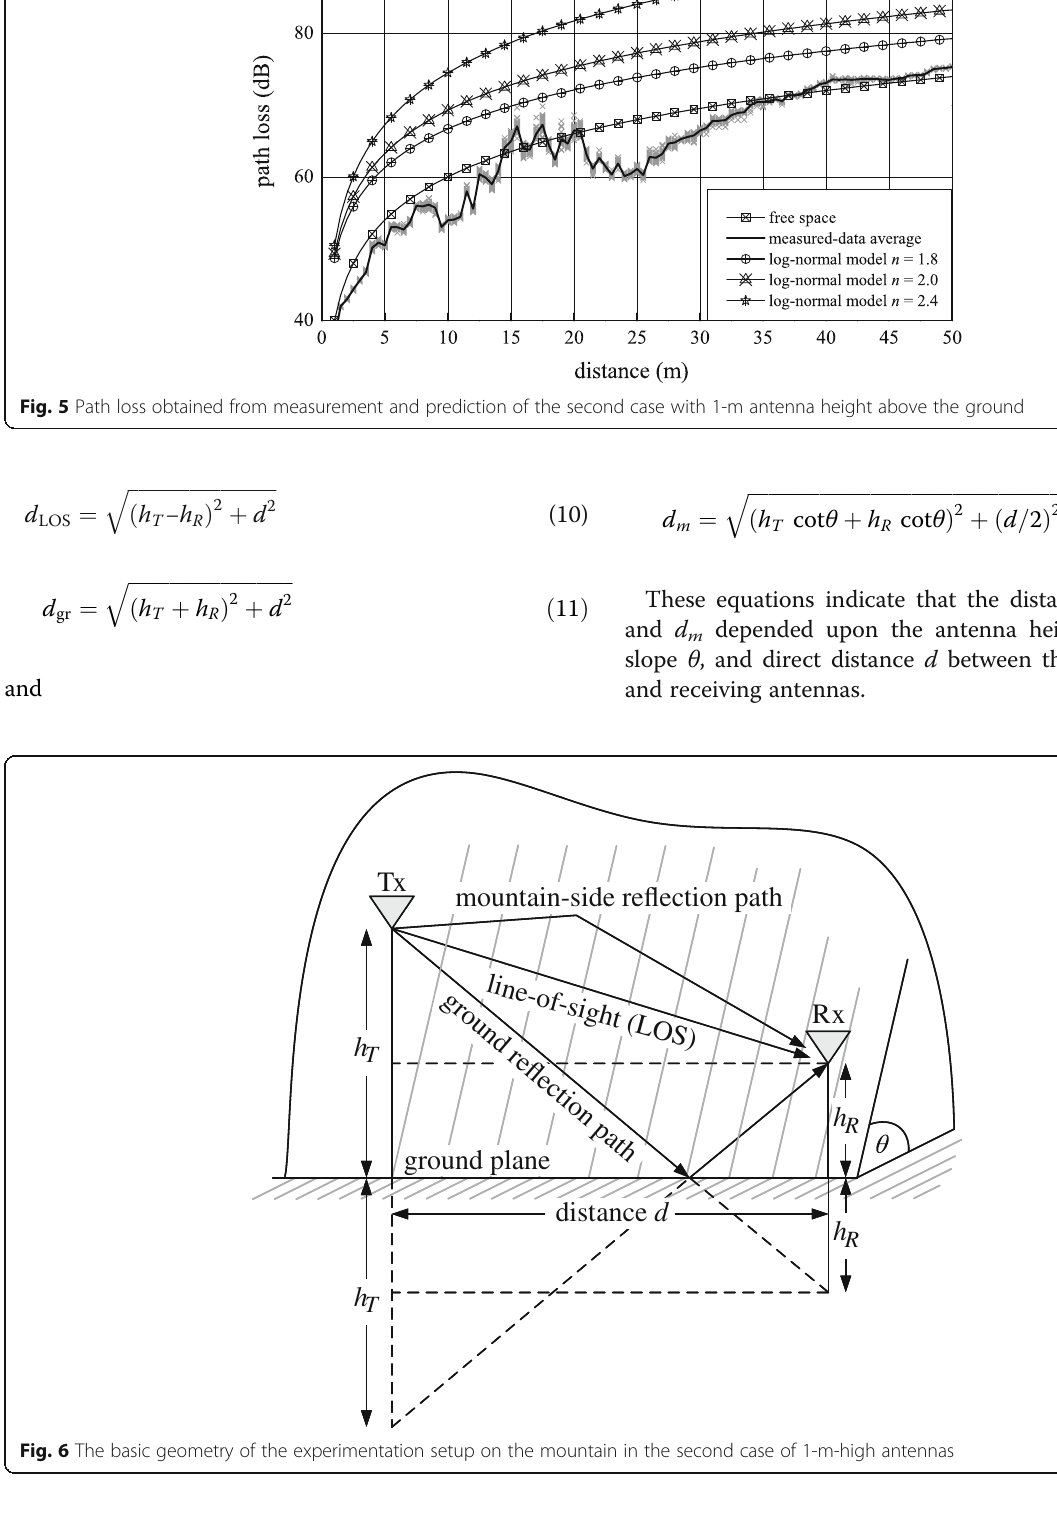
Fig. 6 The basic geometry of the experimentation setup on the mountain in the second case of 1-m-high